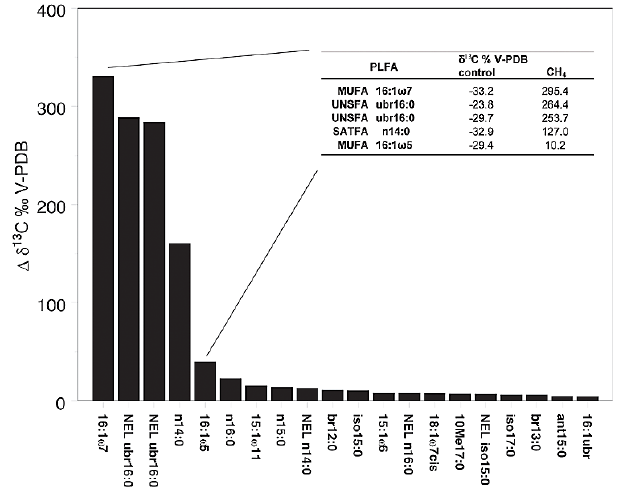
Fig. 3. Ranking of the δ 13 C enrichment in PLFA of SI CH SI. Values of the five most 13 C-enriched lipids are given in the inset table.